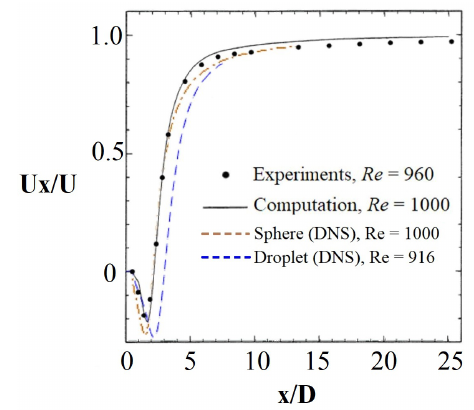
Figure 12. Comparison of the time-averaged stream-wise velocity along the wake symmetry axis for the simulated sphere with Re = 1000 (dashed line), the 3 mm water drop in still air with Re = 916 (dashed line) and the previous studies. The figure is adapted from